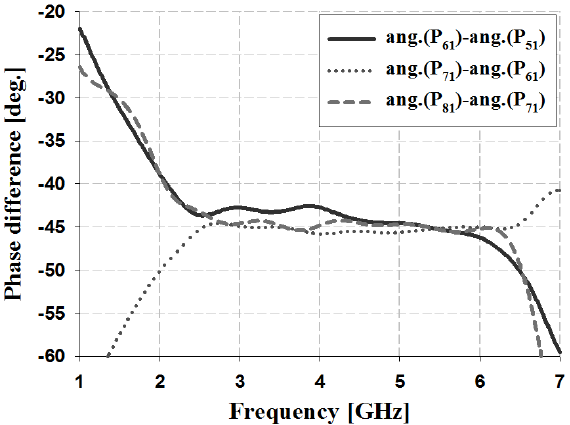
Figure 12. Simulation analysis of phase for input Port 1.